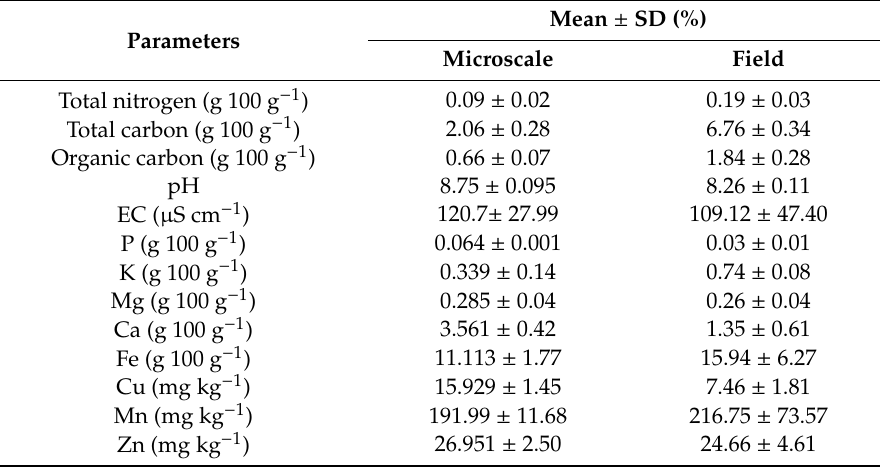
Table 1. Fertility of the soil used in the experimental analysis from the first 15 cm of soil surface. Data on total nitrogen (N), total carbon (C) and organic carbon (CO) and other macro- and micronutrients are shown. Values are means ± SD ( n = 5) at the beginning of the